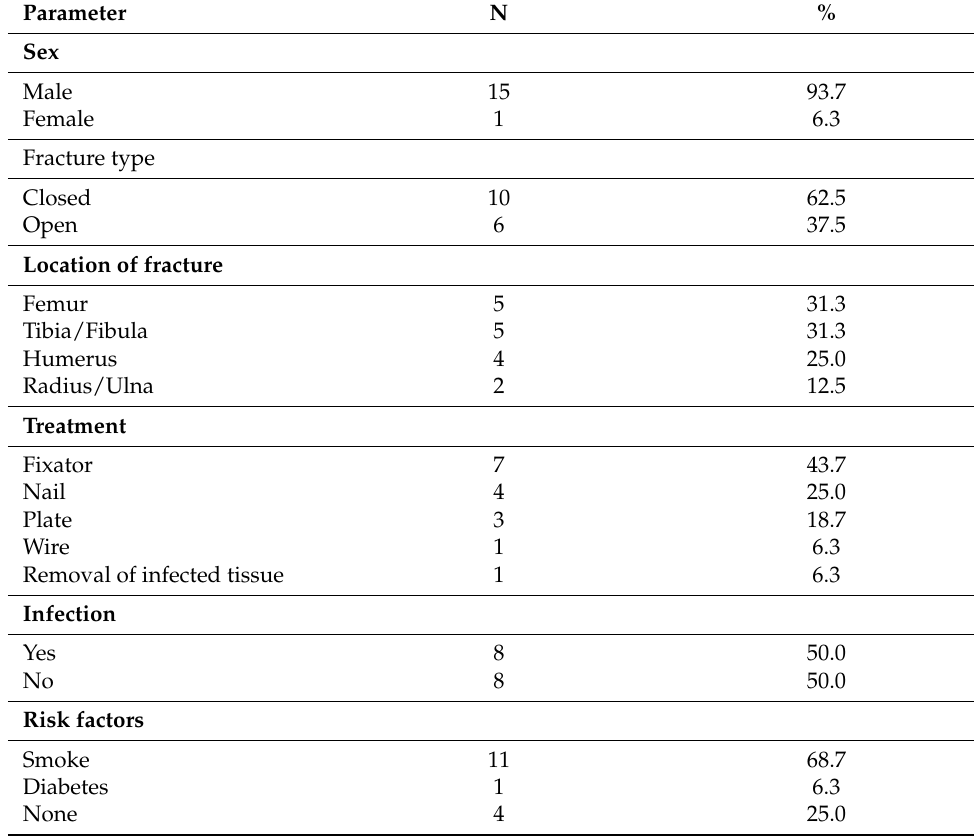
Table 3. Nonunions treated with surgery and LIPUS: demographics and clinical characteristics at baseline.